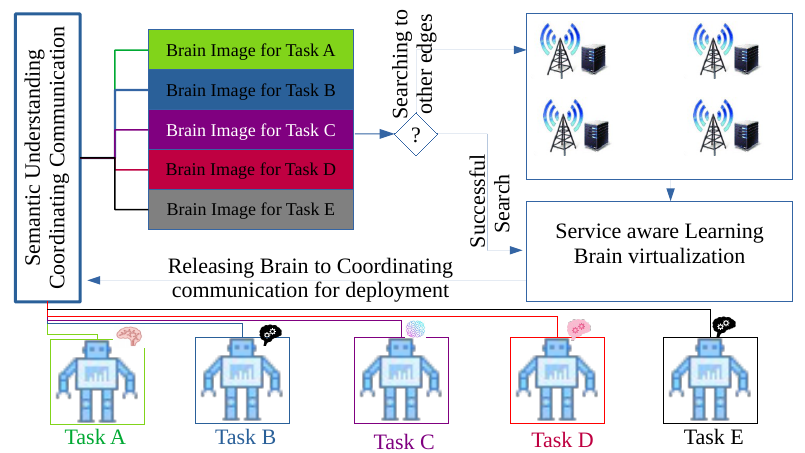
Figure 3. Service-oriented brain searching, learning updates and deployment. (Different colors represent different